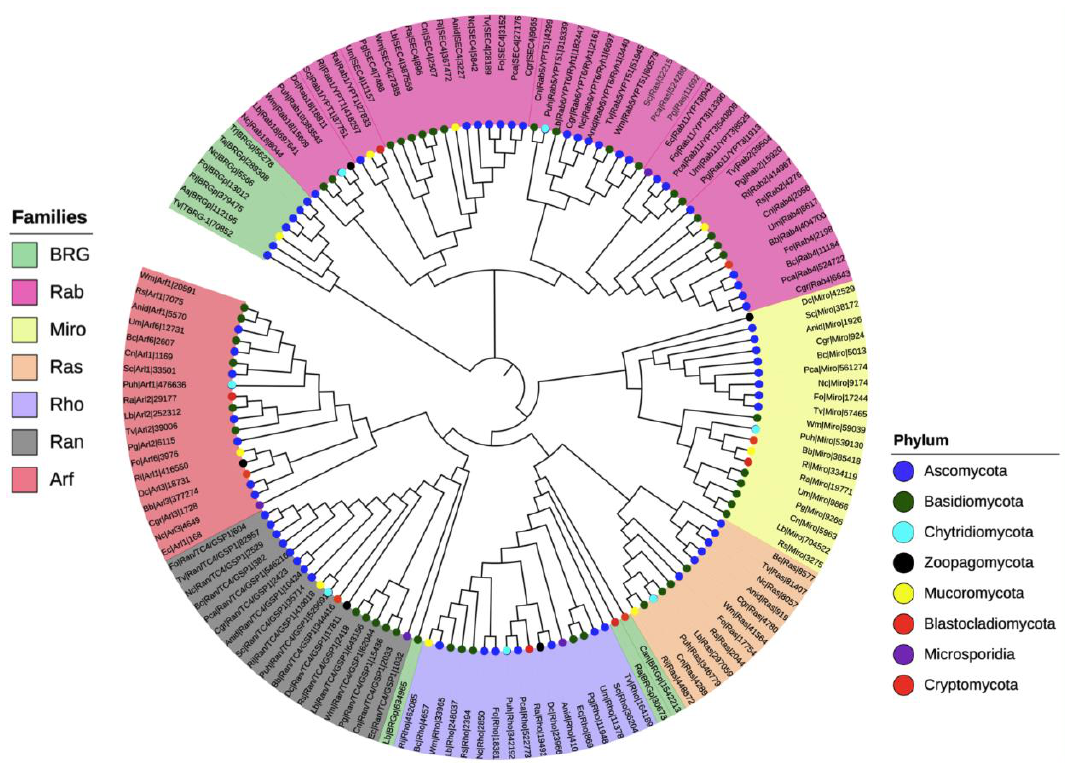
Figure 3. Phylogenetic tree of the seven families of the small Ras GTPases in fungi. The evolutionary history was inferred using the neighbor-joining method [27] using 144 proteins. The bootstrap test was used with 1500 replicates [28]. The evolutionary distances were computed using the Poisson correction method. Evolutionary analyses were conducted in MEGA7 [29]. Colored circles indicate each phylum. For full species names, please refer to Table